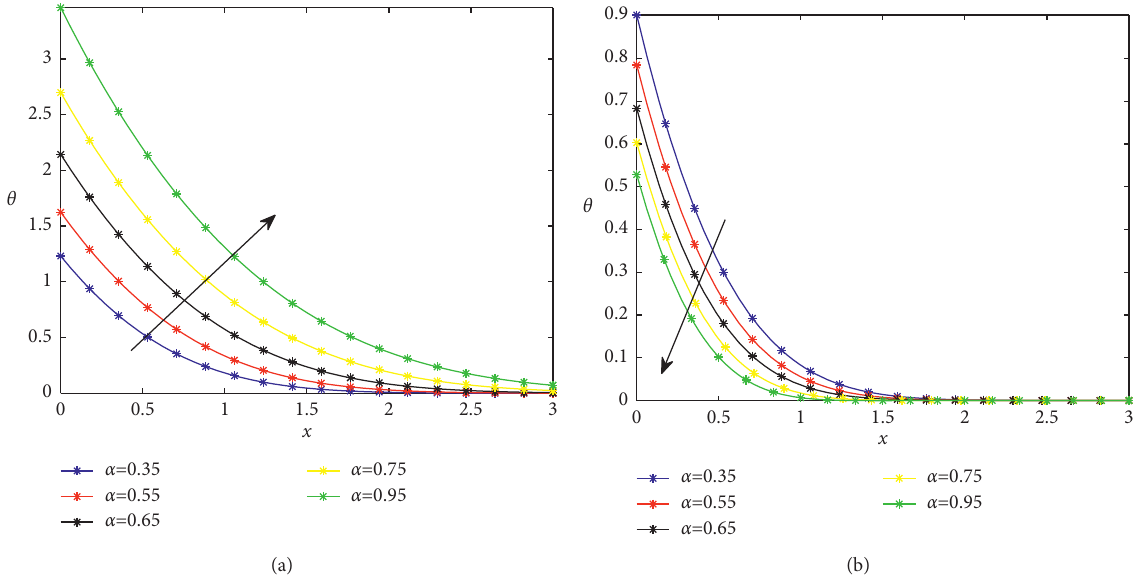
Figure 1: Concentration for different values of the order α . Note. Figures 1(a) and 1(b) are represented with the Schmidt number Sc � 4 and with times τ � 4 (a) and τ � 0 . 4 (b).